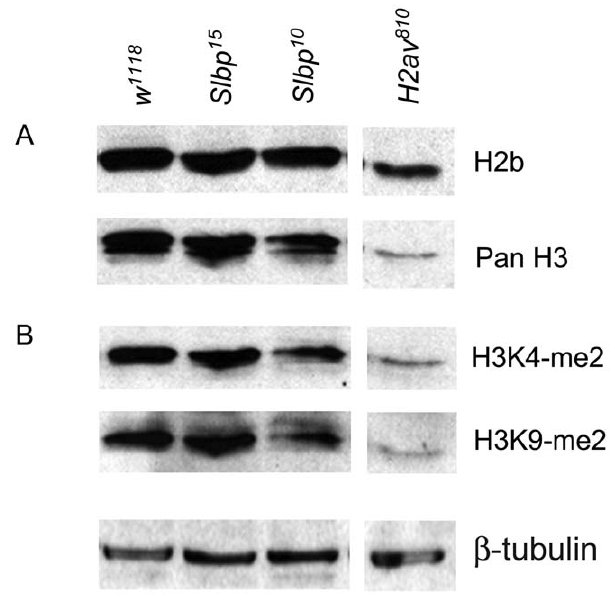
Figure 4. Slbp mutants have no detectable global change in histone protein levels. Protein lysates from wt, Slbp 15 , Slbp 10 , and H2aV 810 mutants were obtained from whole 3 rd instar larvae and probed with antibodies to A) H2b and H3, and B) H3K4-me2 and H3K9- me2. b -tubulin was used as a loading control for both panels.